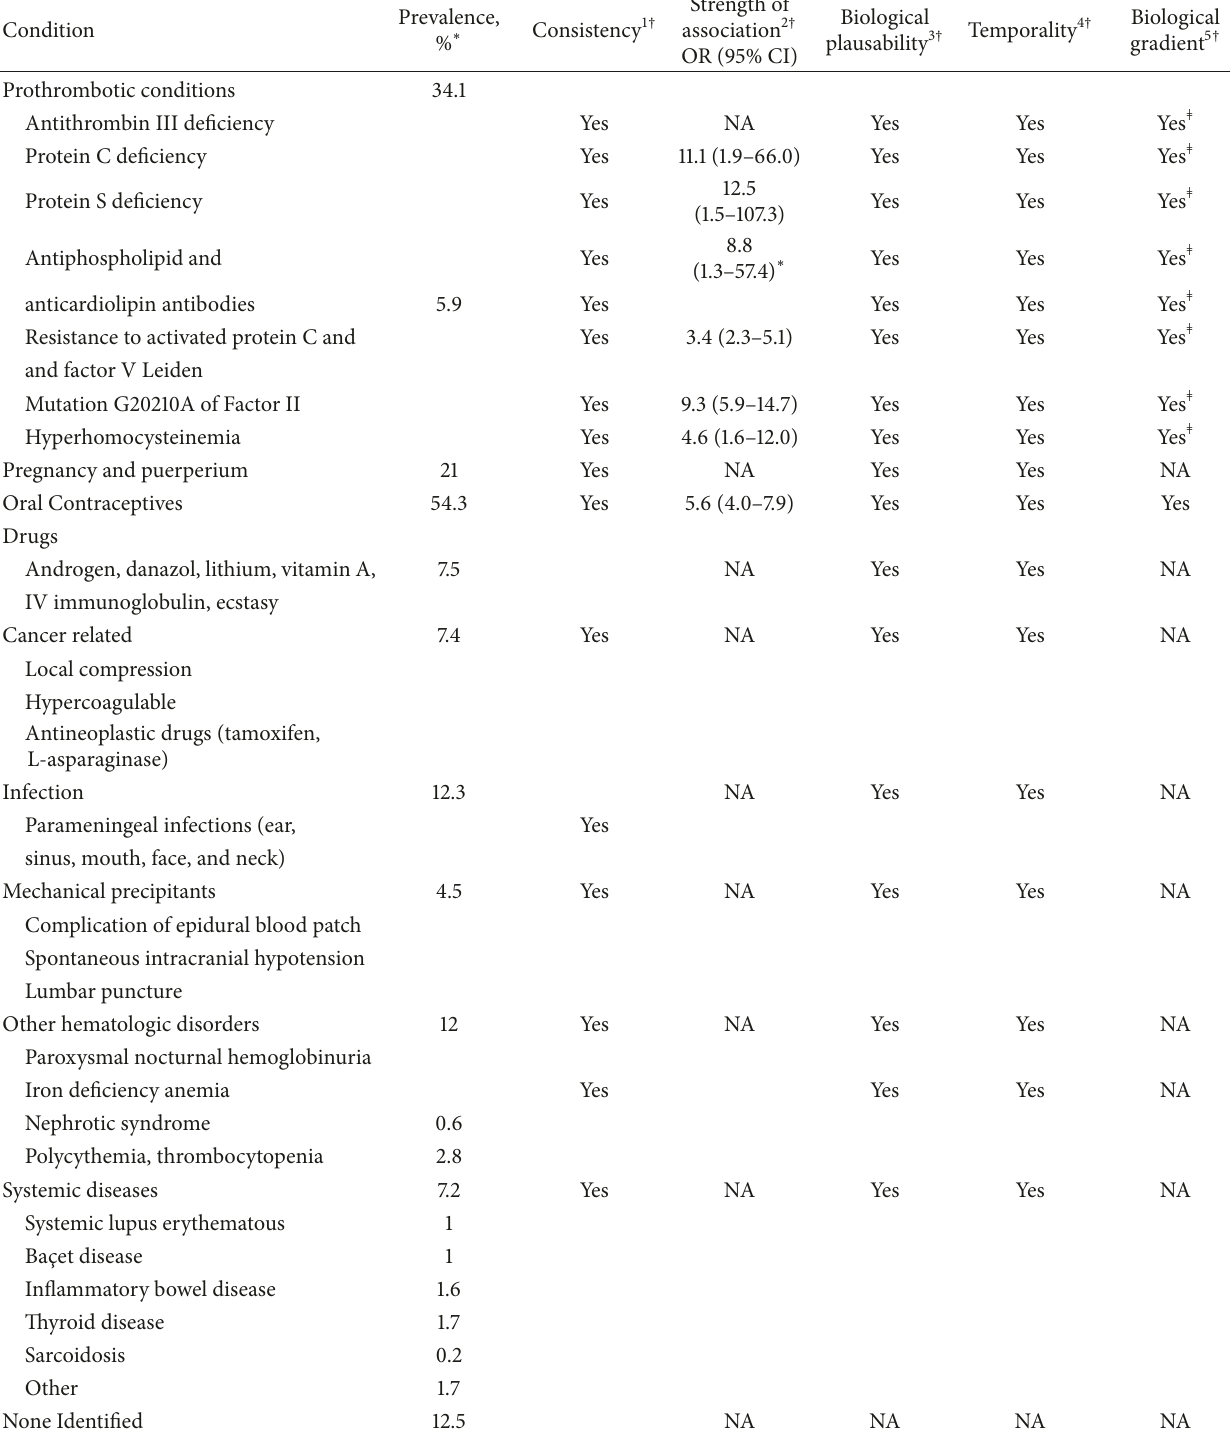
Table 1: Risk dactors for CVT